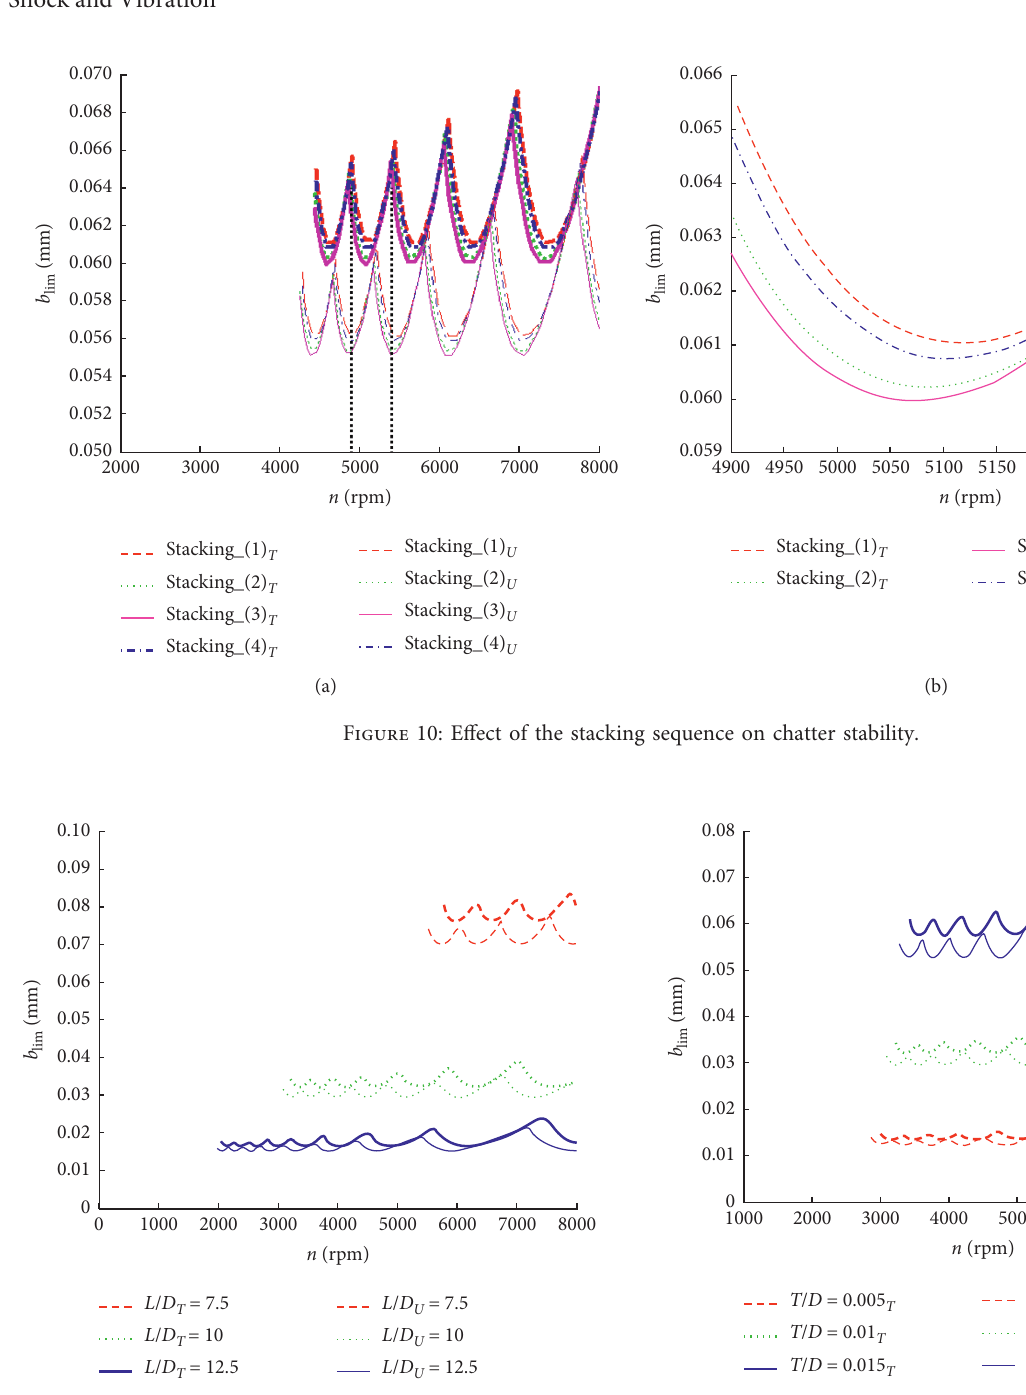
Figure 11: Effect of the L / D ratio on the chatter stability. Figure 12: Effect of the T / D ratio on chatter